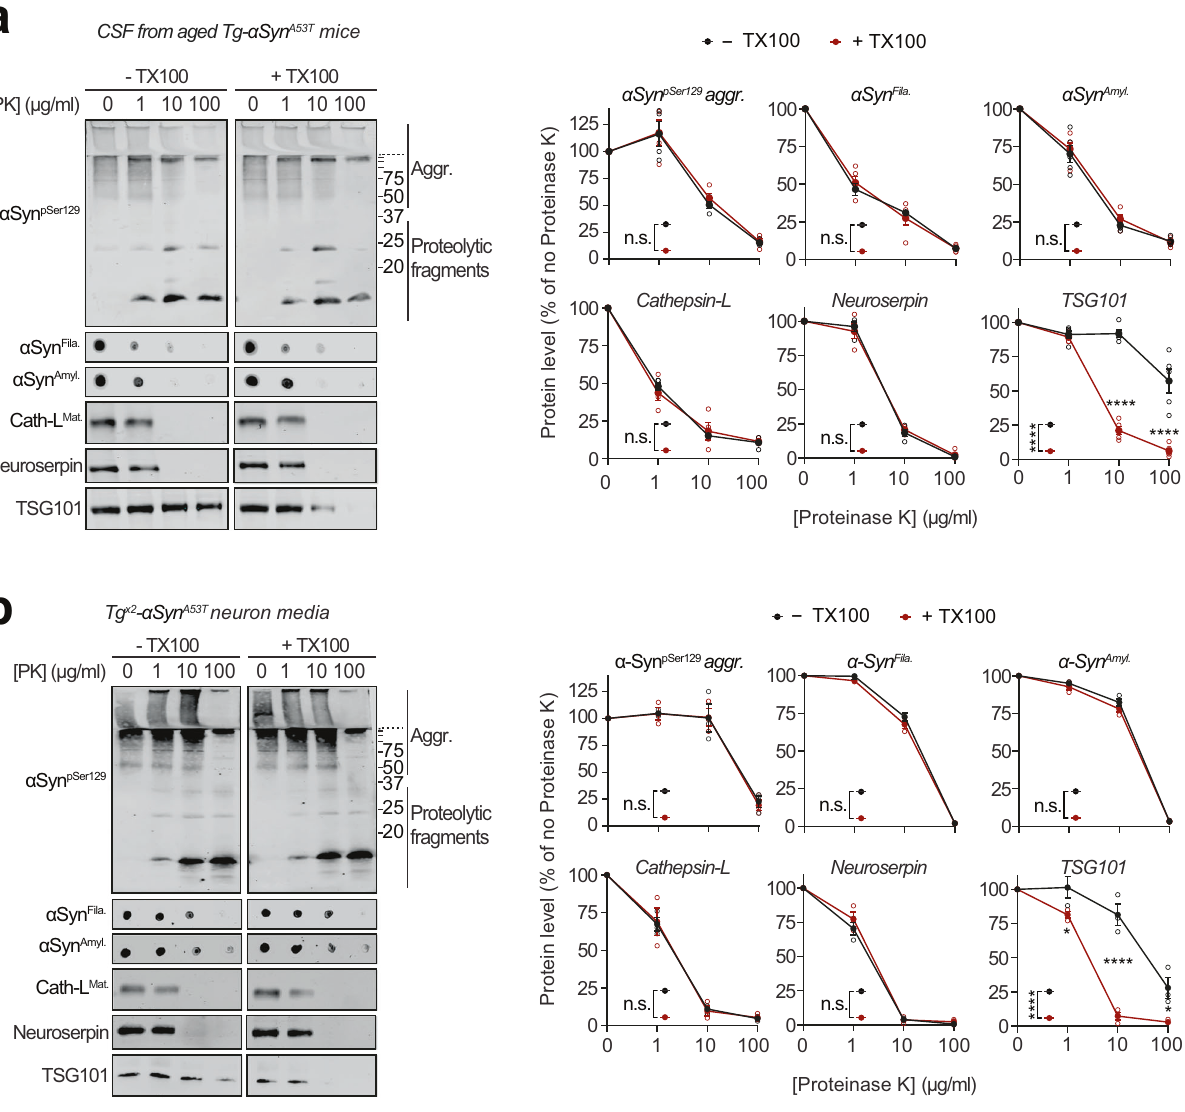
Fig.4 |Extracellular α Synspeciesincerebrospinal fl uidand inprimaryneuron media are not membrane-enveloped. a Cerebrospinal fl uid (CSF) collected from 6-month-oldTg- α Syn A53T miceweresubjectedtolimitedproteolysisusingindicated concentrations of proteinase K (PK) in the absence or presence of 0.1% Triton X-100. Immunoblots for α Syn protein levels ( α Syn pSer129 , α Syn Amyl , and α Syn Fila ), maturecathepsin-L(Cath-L Mat ),TSG101,andneuroserpin( n =5for α Syn Amyl , α Syn Fila ,